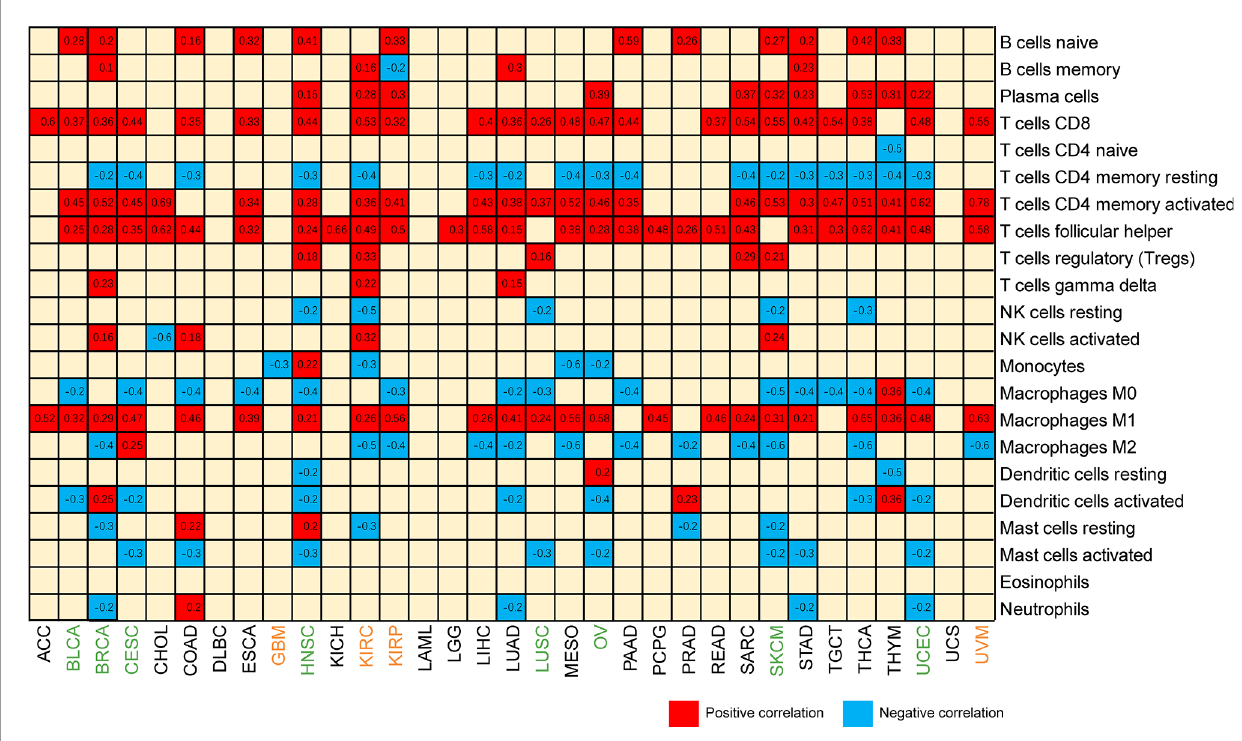
FIGURE 8 | Heatmap of the correlation between CXCL13 expression and in fi ltrating levels of immune cells. Blue represents negative correlation, and red represents positive correlation. Both red and blue represent